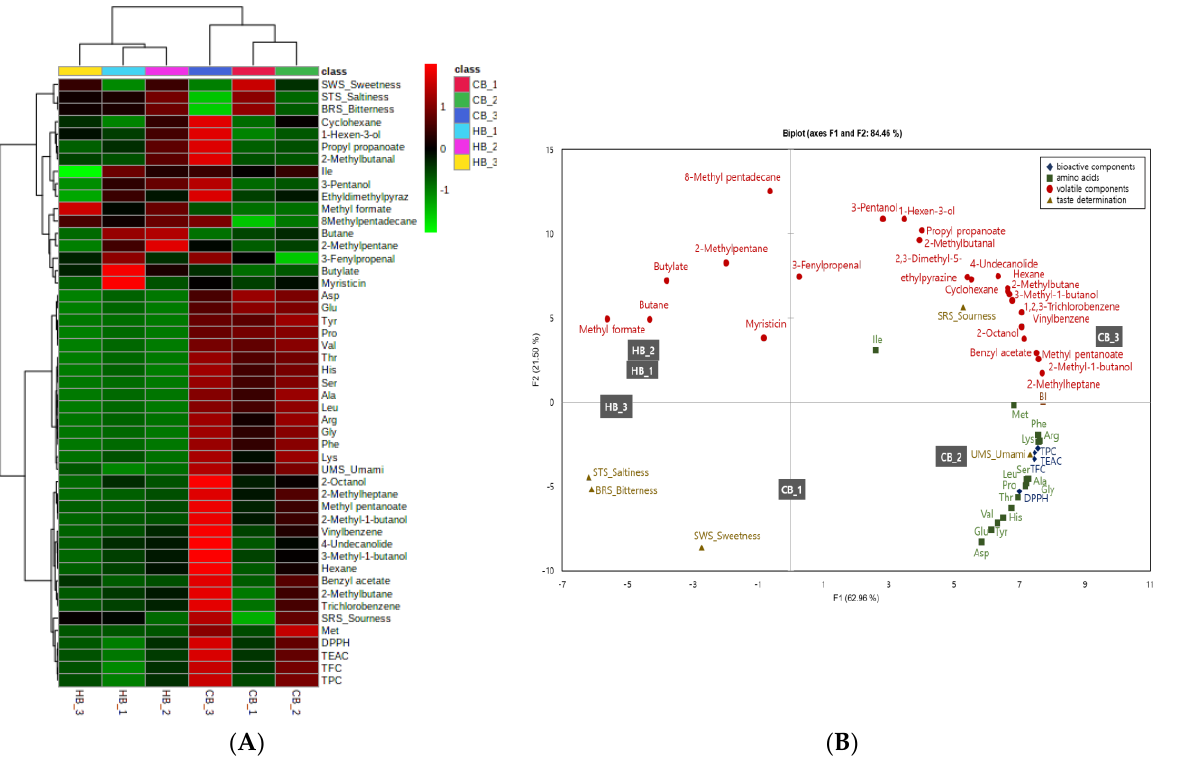
Figure 5. Clustering heatmap ( A ) and principal component analysis (PCA) ( B ) of nutraceutical prop- erties, amino acid compositions, volatile compounds, and the taste profile in hot and cold